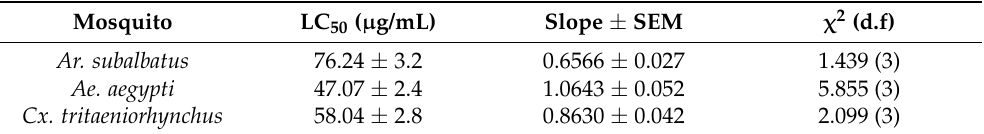
Table 5. Efficacy of the essential oil from C. maxima peels as a potential mosquito larvicidal agent (LC 50 value expressed in µ g/mL).